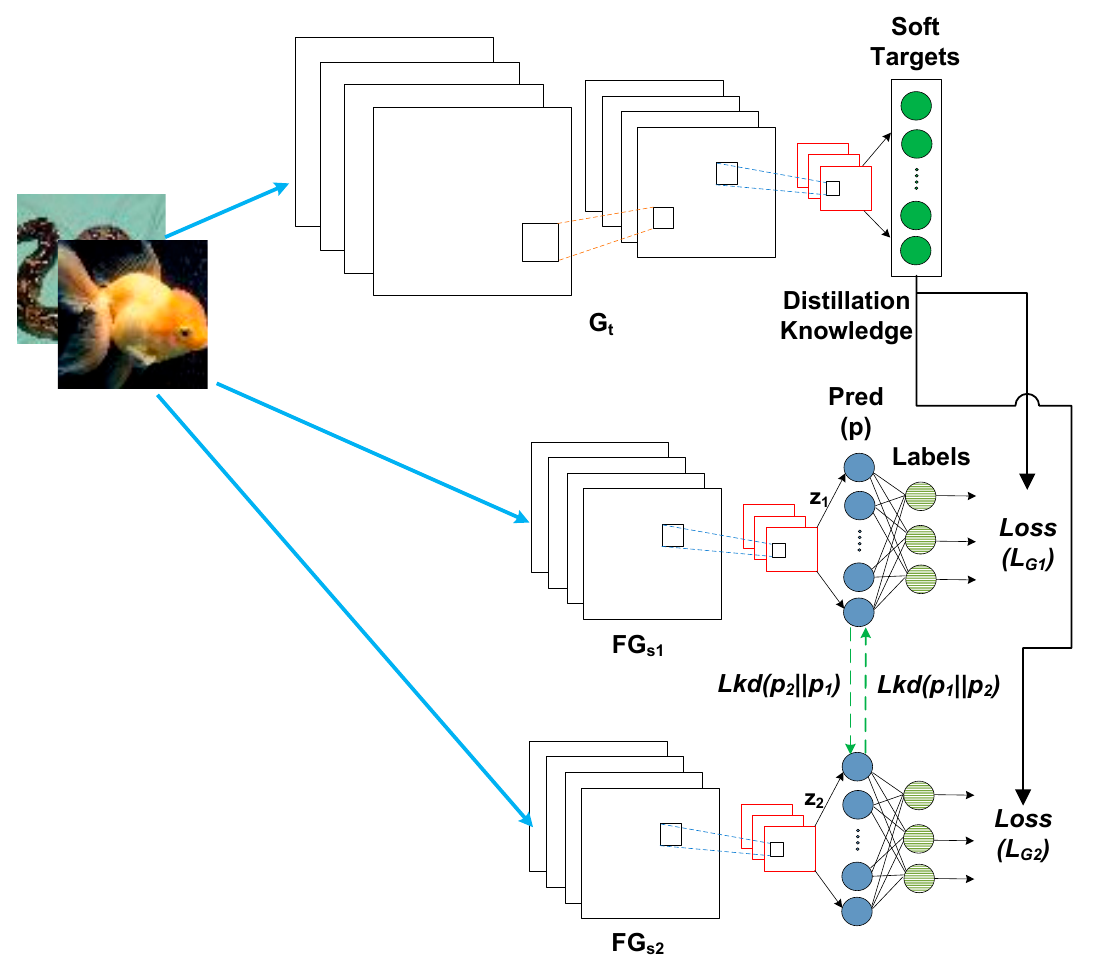
Figure 3. Full deep distillation mutual learning(FDDML) schematic.